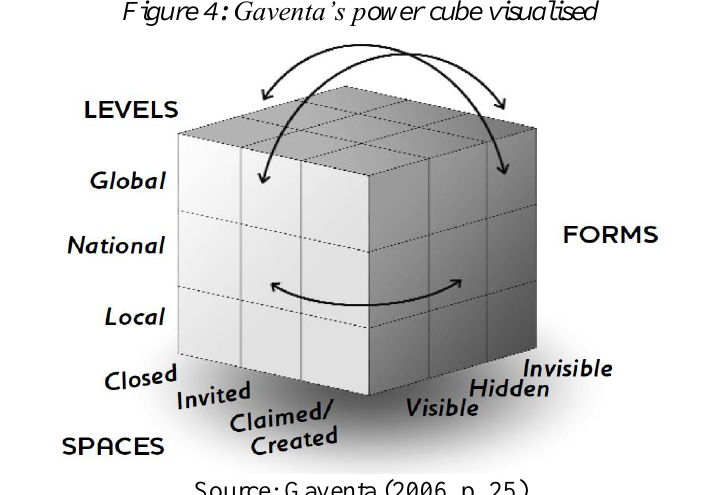
Figure 4: Gaventa’s power cube visualised